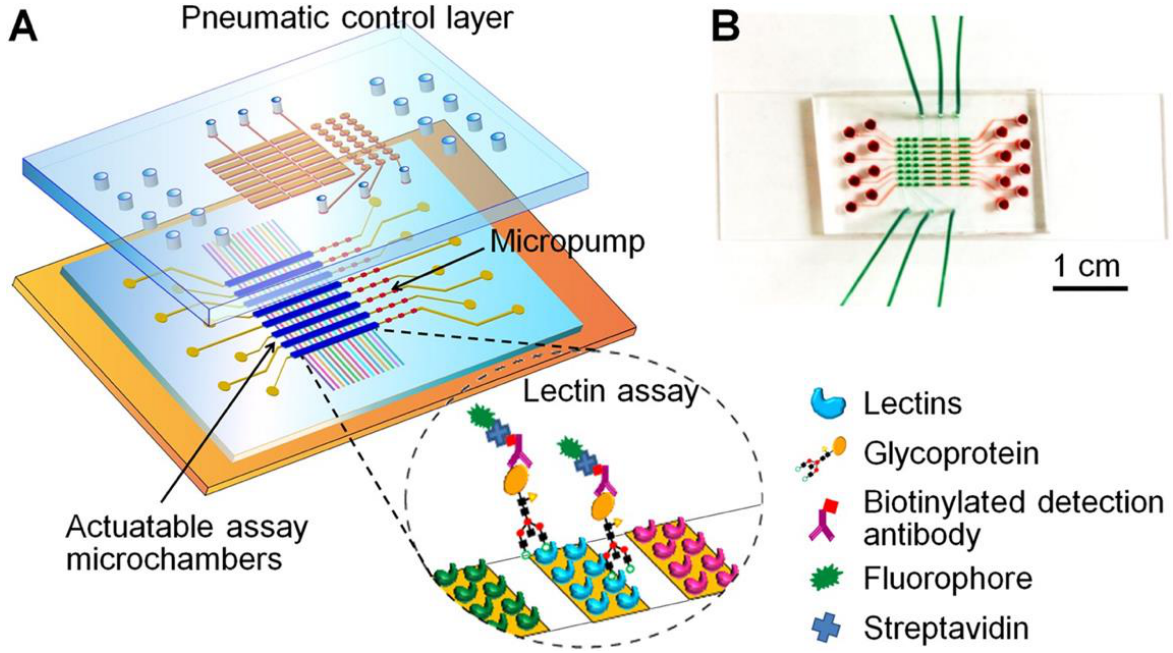
Figure 4. Schematic of the antibody-lectin barcode microfluidic platform proposed by Shang et al. [140]. ( A ) The integrated microfluidic lectin barcode platform contains eight identical microchambers that lay perpendicular to an array of lectins patterned on the chip’s surface. Pneumatic actuation within the assay chamber allows for mixing and capture of glycoproteins to the lectin array. ( B ) Digital image of the microchip with loading chambers in red and pneumatic control layers in green. Reprinted under the Creative Commons CC BY-4.0